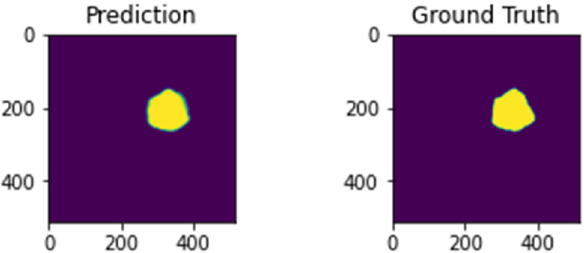
Figure 10: Prediction and ground truth.